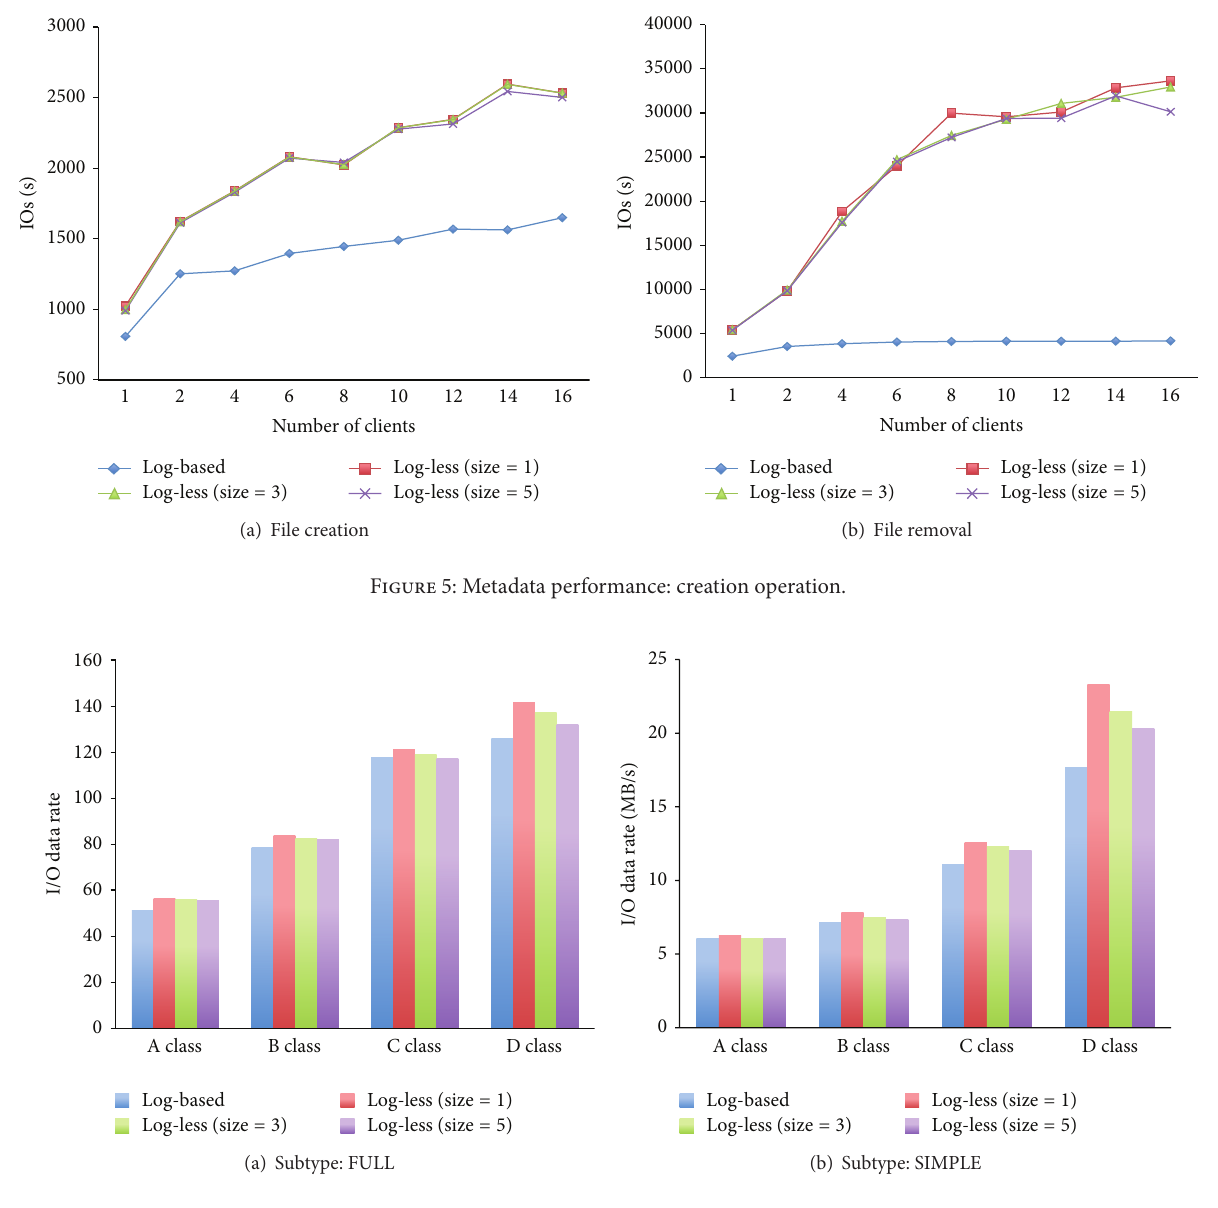
Figure 6: The results of BTIO